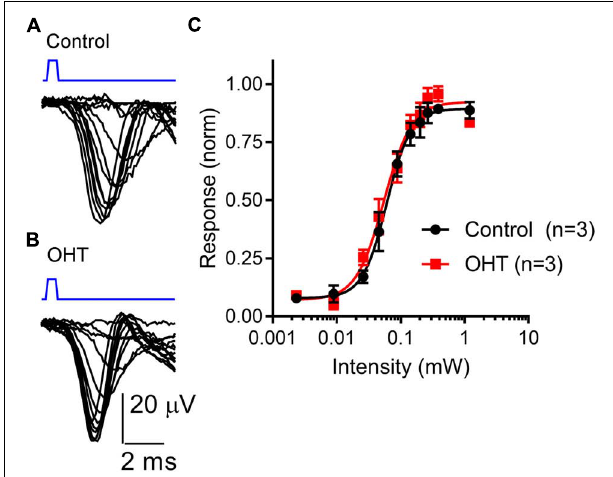
FIGURE 6 | Sensitivity of the optic tract to LED stimulation of ChR2 was not altered by OHT. (A,B) An extracellular electrode was positioned in the optic tract in coronal sections from saline-injected (control) or OHT mice in order to record population spiking in response to ChR2 activation with a series of LED stimulus intensities (2 µ W – 1.2 mW). Each trace is an average of 3–10 individual responses at each intensity. Stimulus timing (0.5 ms LED flash) is marked above the traces in blue. (C) A plot of normalized response amplitudes shows that optic tract sensitivity to ChR2 was not altered by OHT.